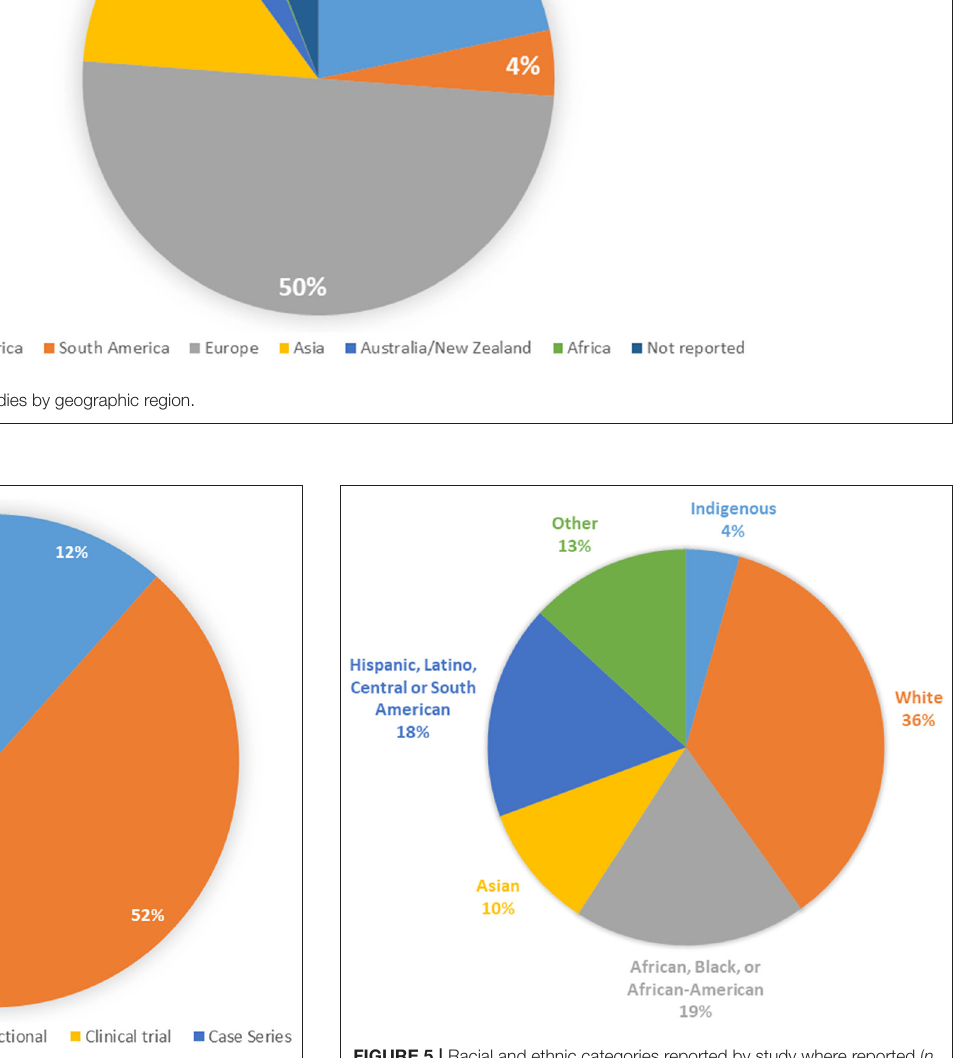
secondary progressive MS (SPMS) ( n = 88, 16.2%) and primary progressive MS (PPMS) ( n = 75,